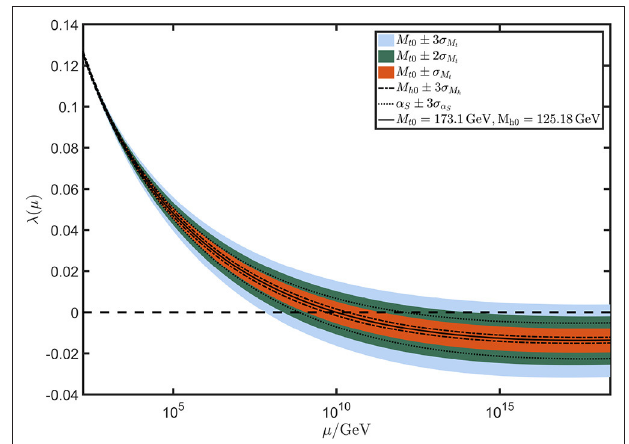
FIGURE 3 | RG evolution of the Higgs four-point coupling. The bands represent uncertainties up to 3 σ coming from the mass of the Higgs, the top quark and the strong coupling constant M h , M t and α S , respectively, using central values (Tanabashi et al., 2018) of M h 125.18 0.16GeV, = ± M t 173.1 0.9GeV, α S 0.1181 = ± = ±